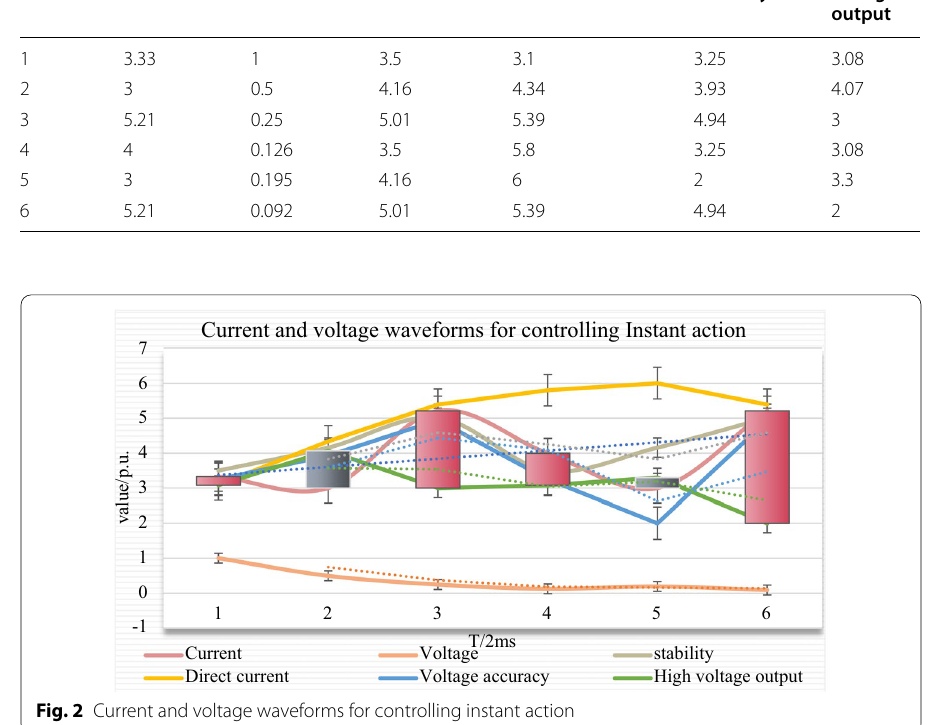
Table 1 Current and voltage detection results when the voltage transformer fails Num